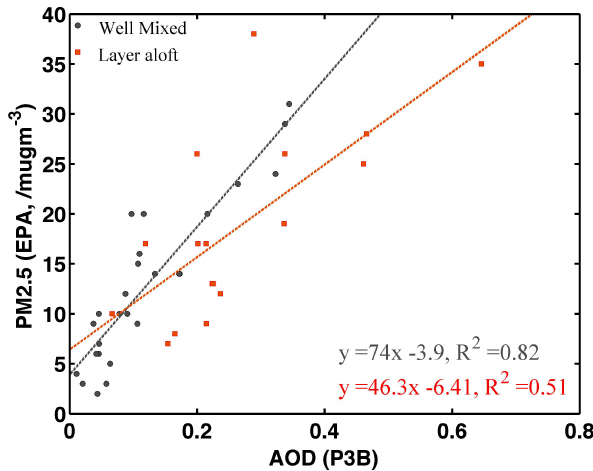
Fig. 6. PM 2 . 5 measured from the EPA ground sites (Beltsville, Edgewood and Fairhill) as a function of the AOD 550 nm calculated using extinction profiles performed by the P-3B when an elevated aerosol layer aloft the BL was observed (red squares) or absent (black